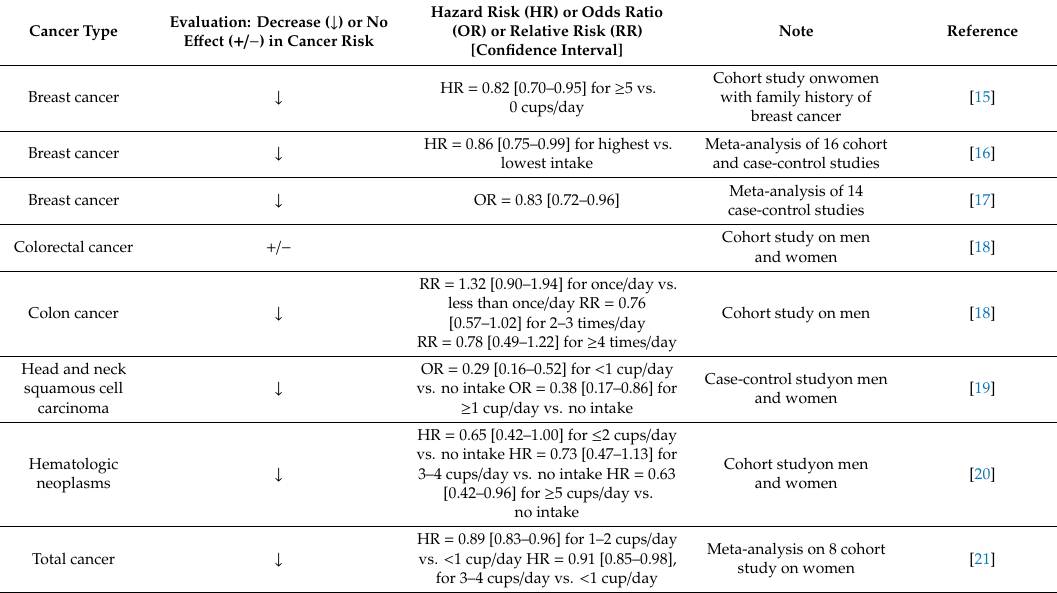
Table 1. Recent observational epidemiological studies on anti-cancer e ff ects of green tea. Cancer